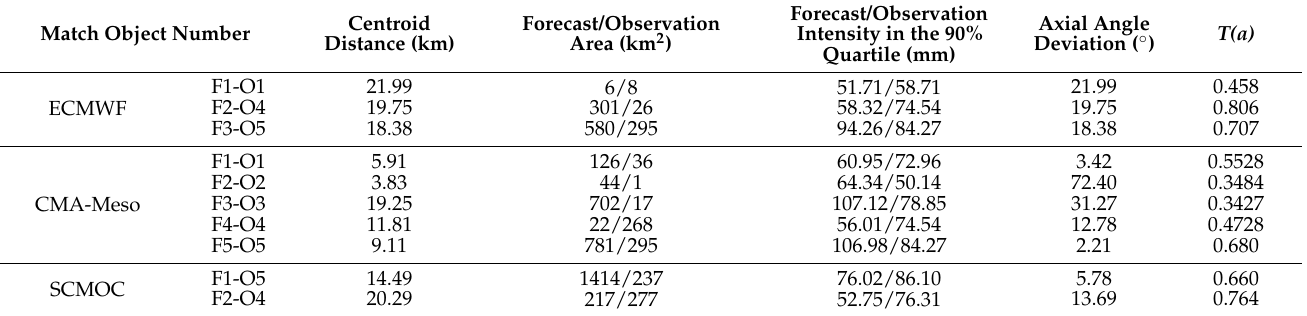
Figure 5. MODE method verifies statistical results for 74 rainstorm cases. ( a ) Number of independent objects changes with area; the x -axis and y -axis are the area and number of objects, respectively. ( b ) Intensity of independent objects with area; the x -axis and y -axis are the area and intensity of objects, respectively. ( c ) The similarity of clustered matching objects with centroid distance; the x -axis and y -axis are T(a) and centroid distance of objects, respectively. ( d ) The scatter plot of the overlap area of clustered matched objects. Table 2. Corresponding property table of the clustered matching objects of precipitation cases. In the matching object number, “F” indicates the forecast and “O” indicates the